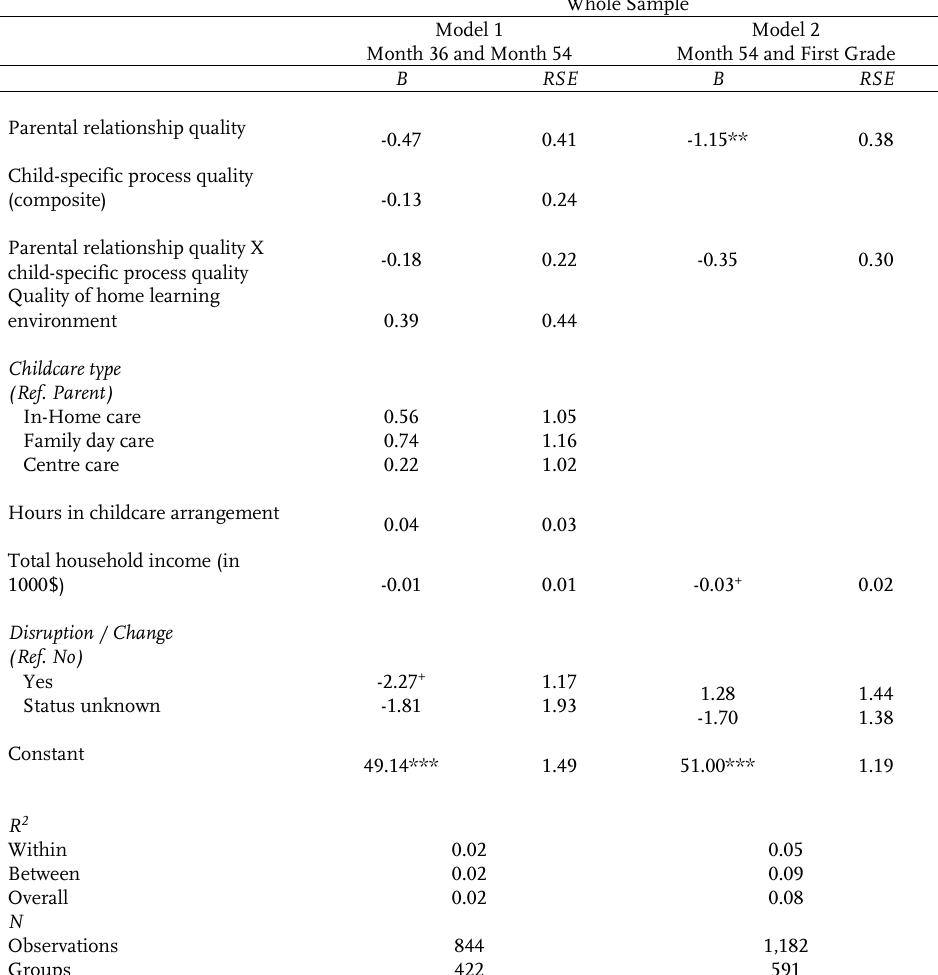
Table 4 : Fixed-effects models of child behavior checklist scores, month 36 through first grade, with ORCE A Priori Qualitative Composite of Process Quality Whole